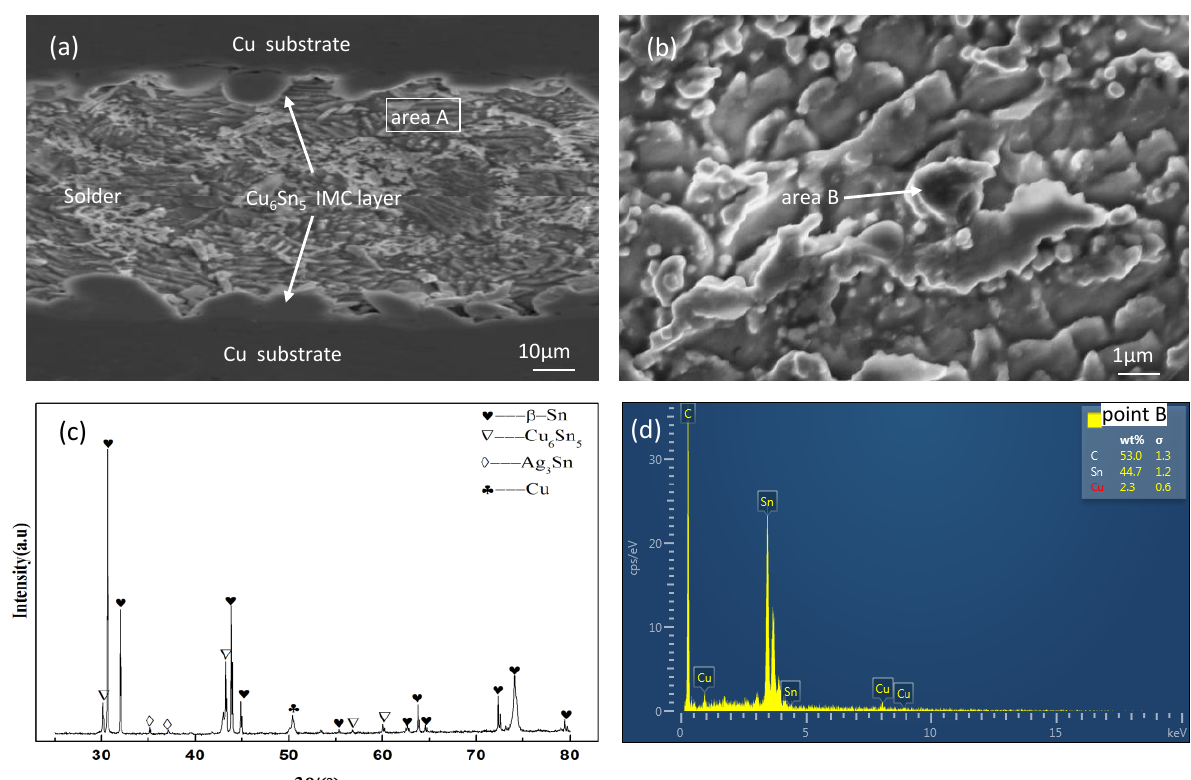
Figure 3. Solder joint microstructure. ( a ) SEM image of solder point microstructure. ( b ) High − power SEM image of Region A. ( c ) XRD analysis spectrogram of Region A. ( d ) EDS analysis spectrogram of Region B.